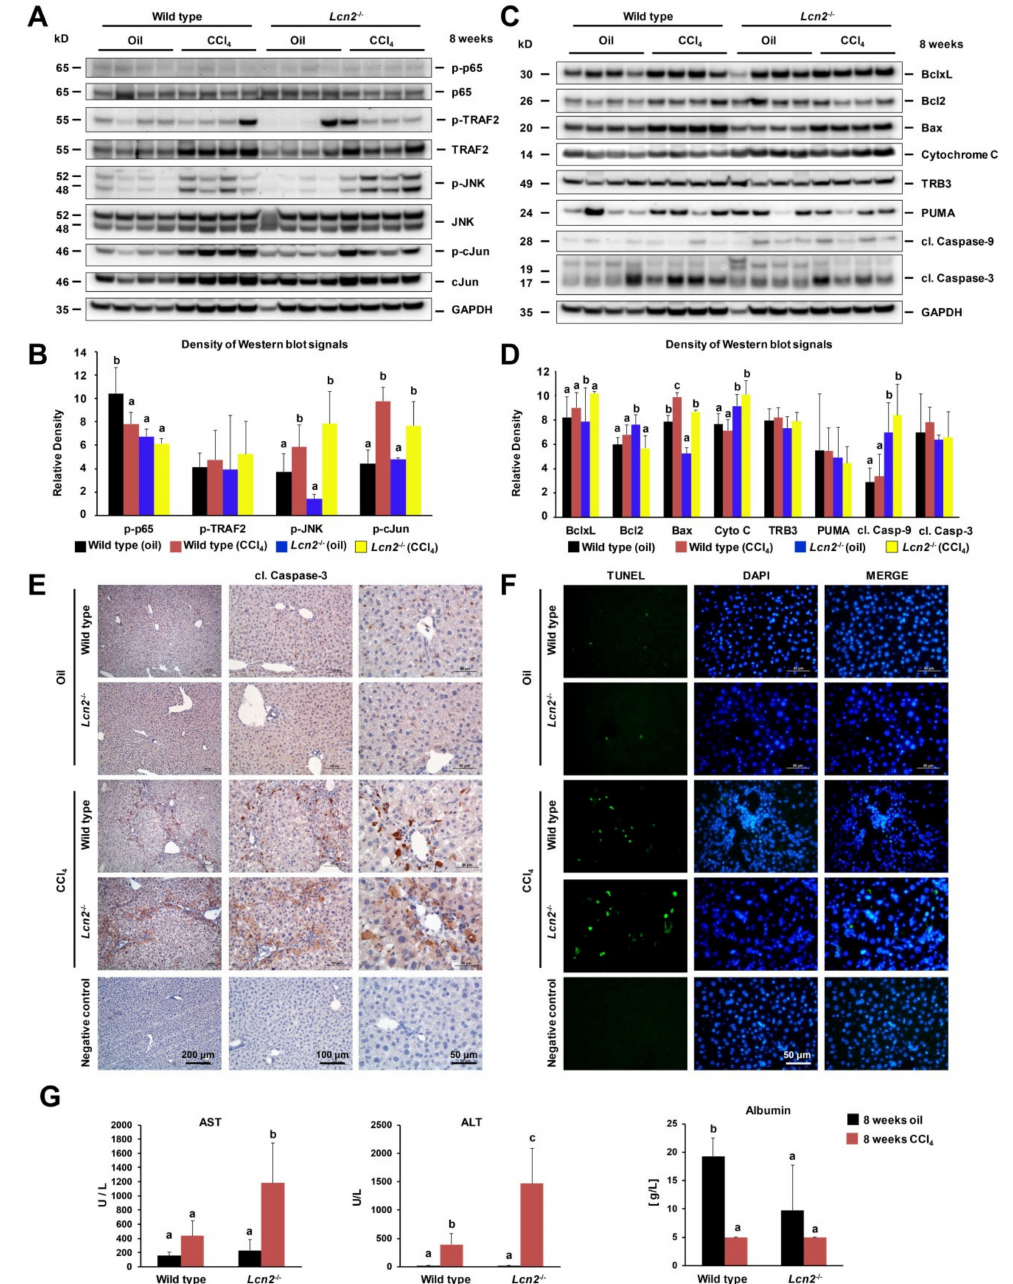
Figure 2. Chronic CCl 4 -induced hepatocyte apoptosis via JNK / c-Jun and mitochondrial pathways. ( A ) Western blot analysis and ( B ) quantification of p65 NF- κ B, TRAF2, p-JNK, JNK, p-c-Jun, and